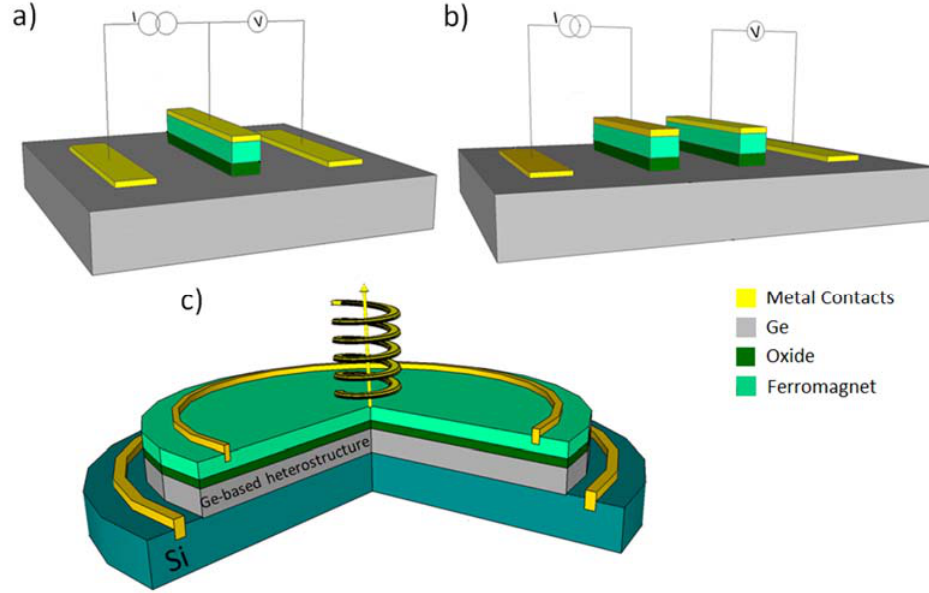
Figure 6. Schematic representations of ( a ) three ‐ terminal and ( b ) four ‐ terminal Ge ‐ based devices used in electrical spin injection experiments. ( c ) Possible layout of a prototype of a Ge ‐ based spin ‐ LED . Drawings not to scale.